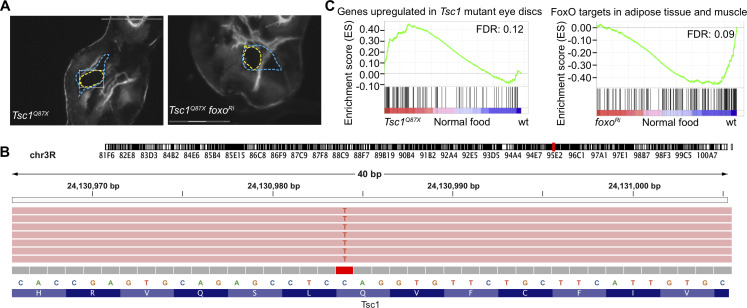
Contamination status of isolated clones.(A) Representative images of isolated Tsc1Q87X and Tsc1Q87X foxoRi clones. Blue dashed lines mark the GFP-negative clones from which the selected clones (outlined in yellow) were isolated. Scale bar = 150 µm. (B) Mapping of sequences from Tsc1Q87X foxoRi cells isolated from a larva raised under NR to the Tsc1 locus at the position of Q87X point mutation using Integrative Genomics Viewer (Robinson et al., 2011). (C) GSEA plots depicting correlation between differentially expressed genes in Tsc1 mutant cells as compared to wild-type on normal food and genes upregulated in Tsc1 mutant eye discs (Harvey et al., 2008), and differentially expressed genes in wild-type versus foxo knockdown cells on normal food and FoxO targets (Teleman et al., 2008).